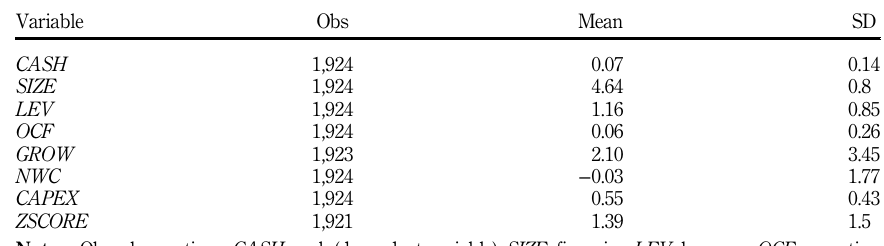
Table II. Descriptive statistics for overall